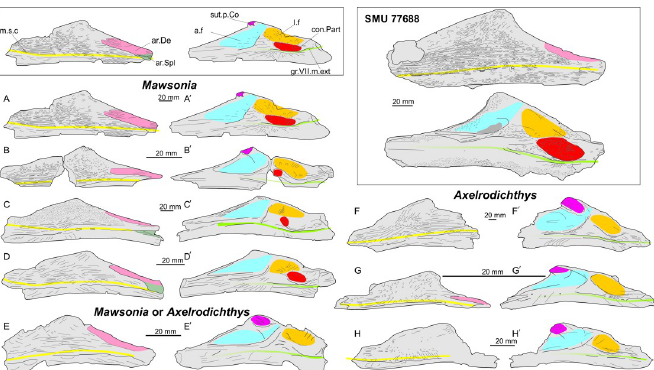
Fig 3. Comparison of the angular of the Woodbine Fm (upper right frame) with Mawsonia specimens (A-D) and Axelrodichthys specimens (F-H), and Mawsonia or Axelrodichthys in labial (A-H) and lingual (A’-H’) views. Left small frame, anatomical features. Abbreviations: a.f, aductor fossa (blue); ar.De: articular surface for dentary (pink); ar.Spl: articular surface for splenial (grey); con.Part, contact surface with prearticular (red); gr.VII.m.ext groove for external mandibular ramus of VII (green); l.f, longitudinal fossa (orange); m.s.c, mandibular sensory canal (yellow); sut.p.Co, sutural contact surface with principal coronoid